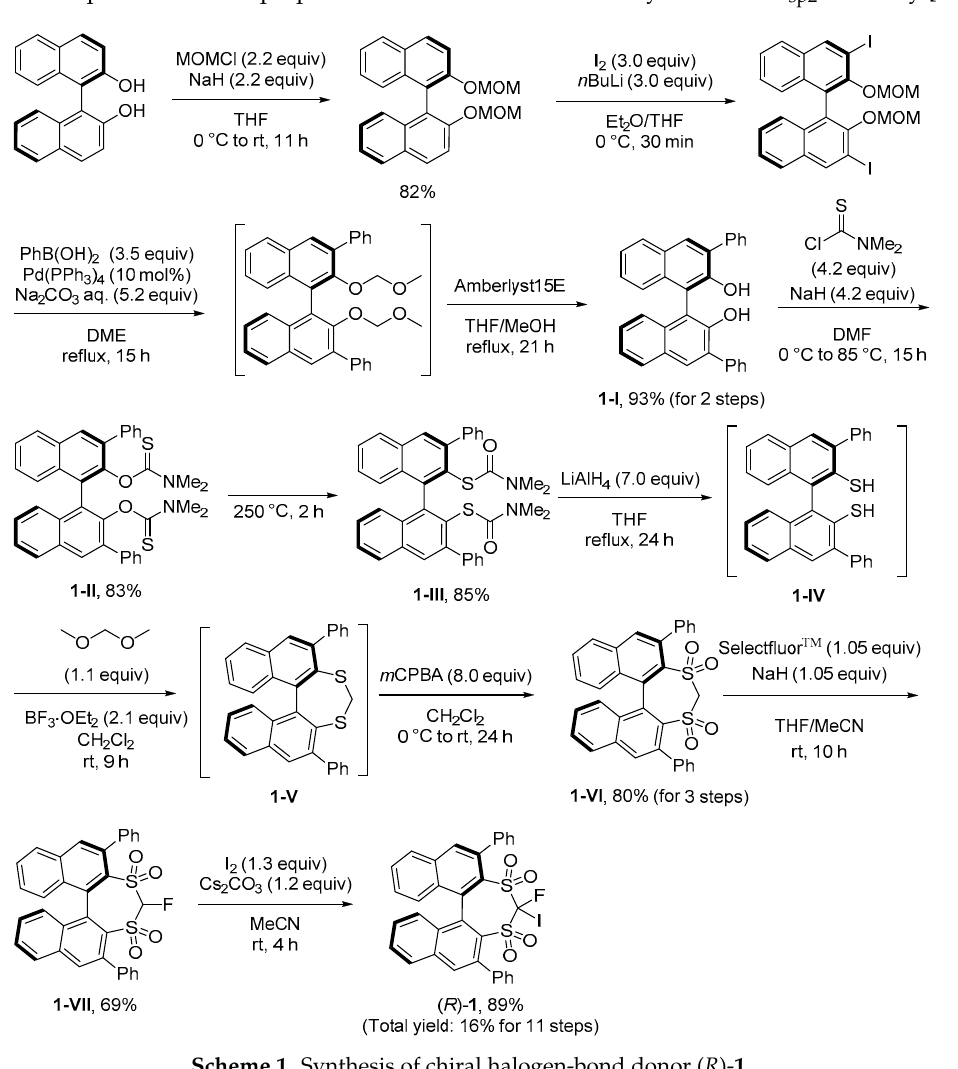
Figure 2. Design of a chiral halogen-bond donor ( R )- 1 with a sp 3 -hybridized carbon–iodine moiety .